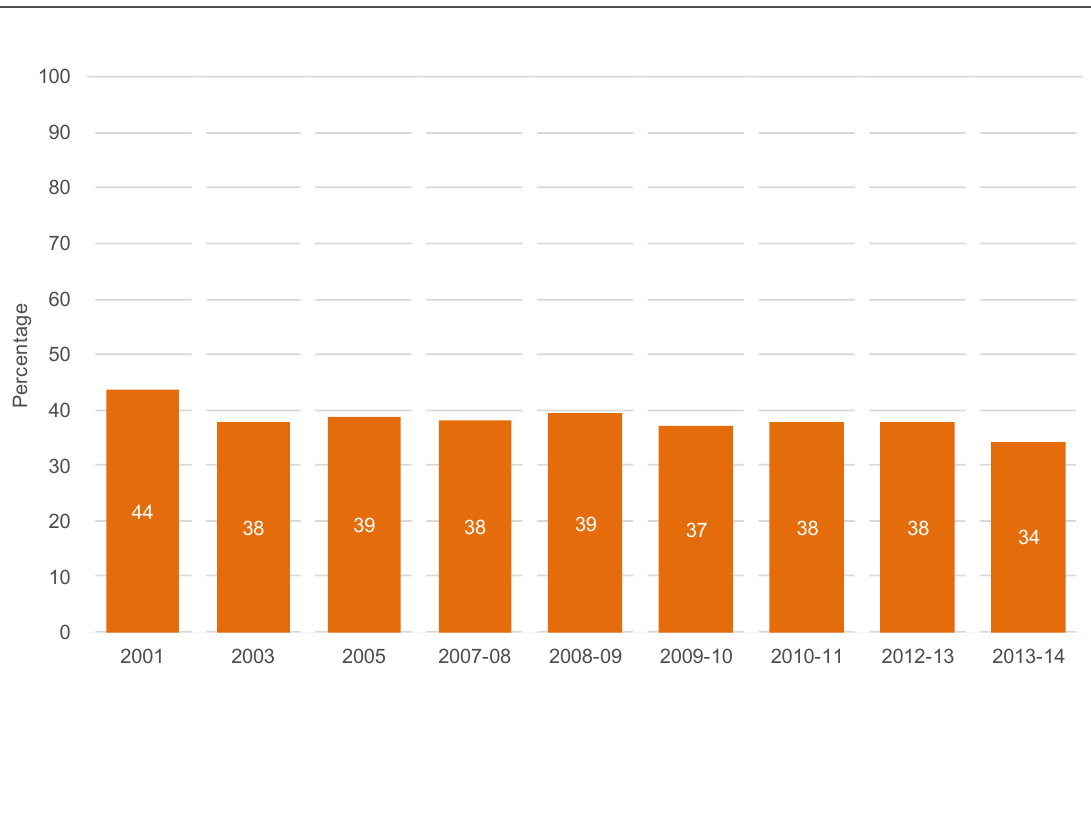
Figure 18: Proportion of people who feel they can influence decisions affecting their local area, 2001 to